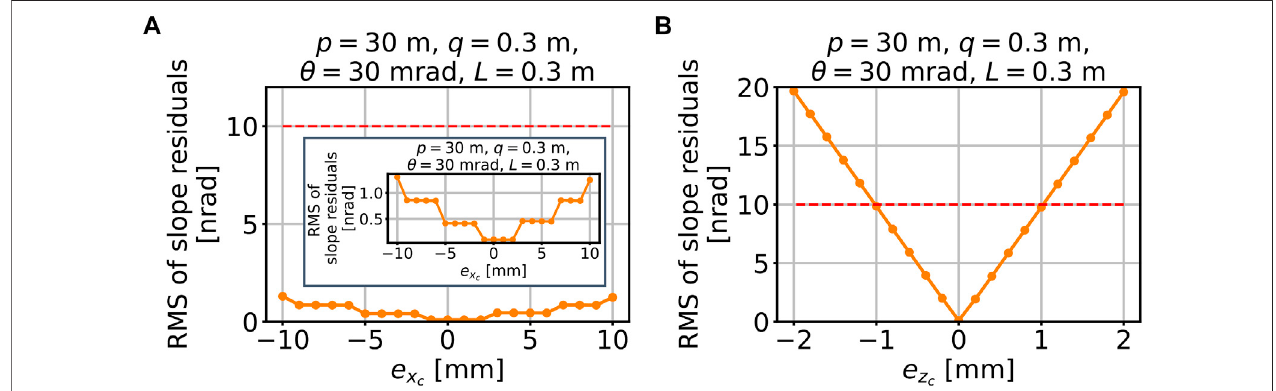
FIGURE 5 | Simulation with the default ellipse demonstrates the tolerance of e z RMS within ± 10 mm range. (B) the slope residuals due to e z